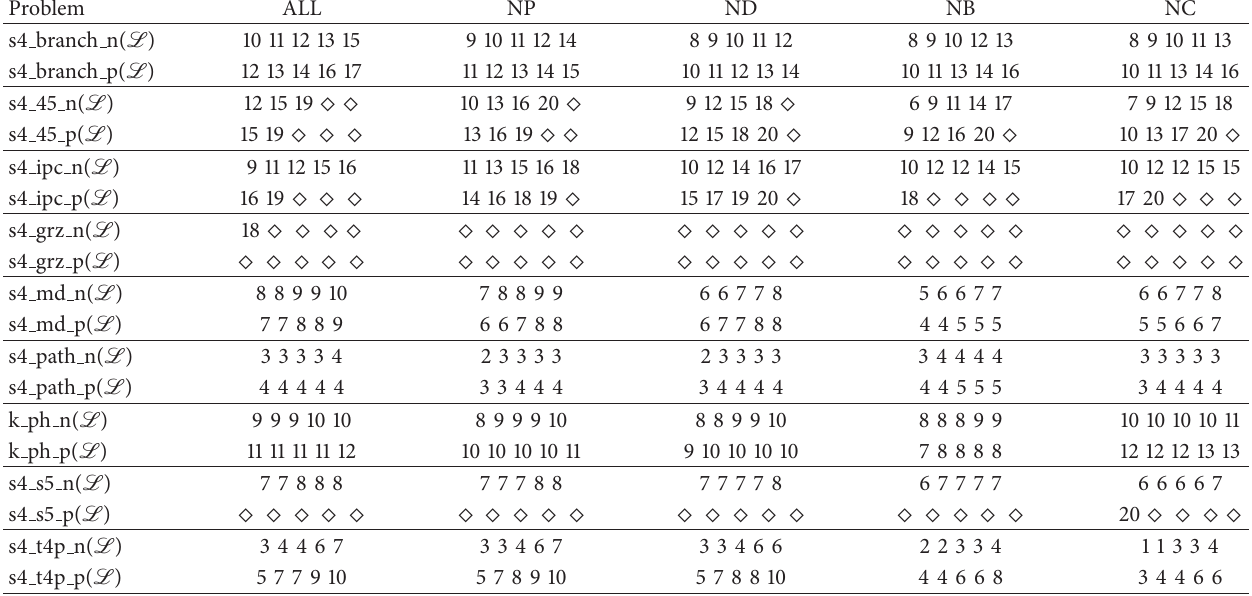
Table 6: Results for S4( L ) tests.